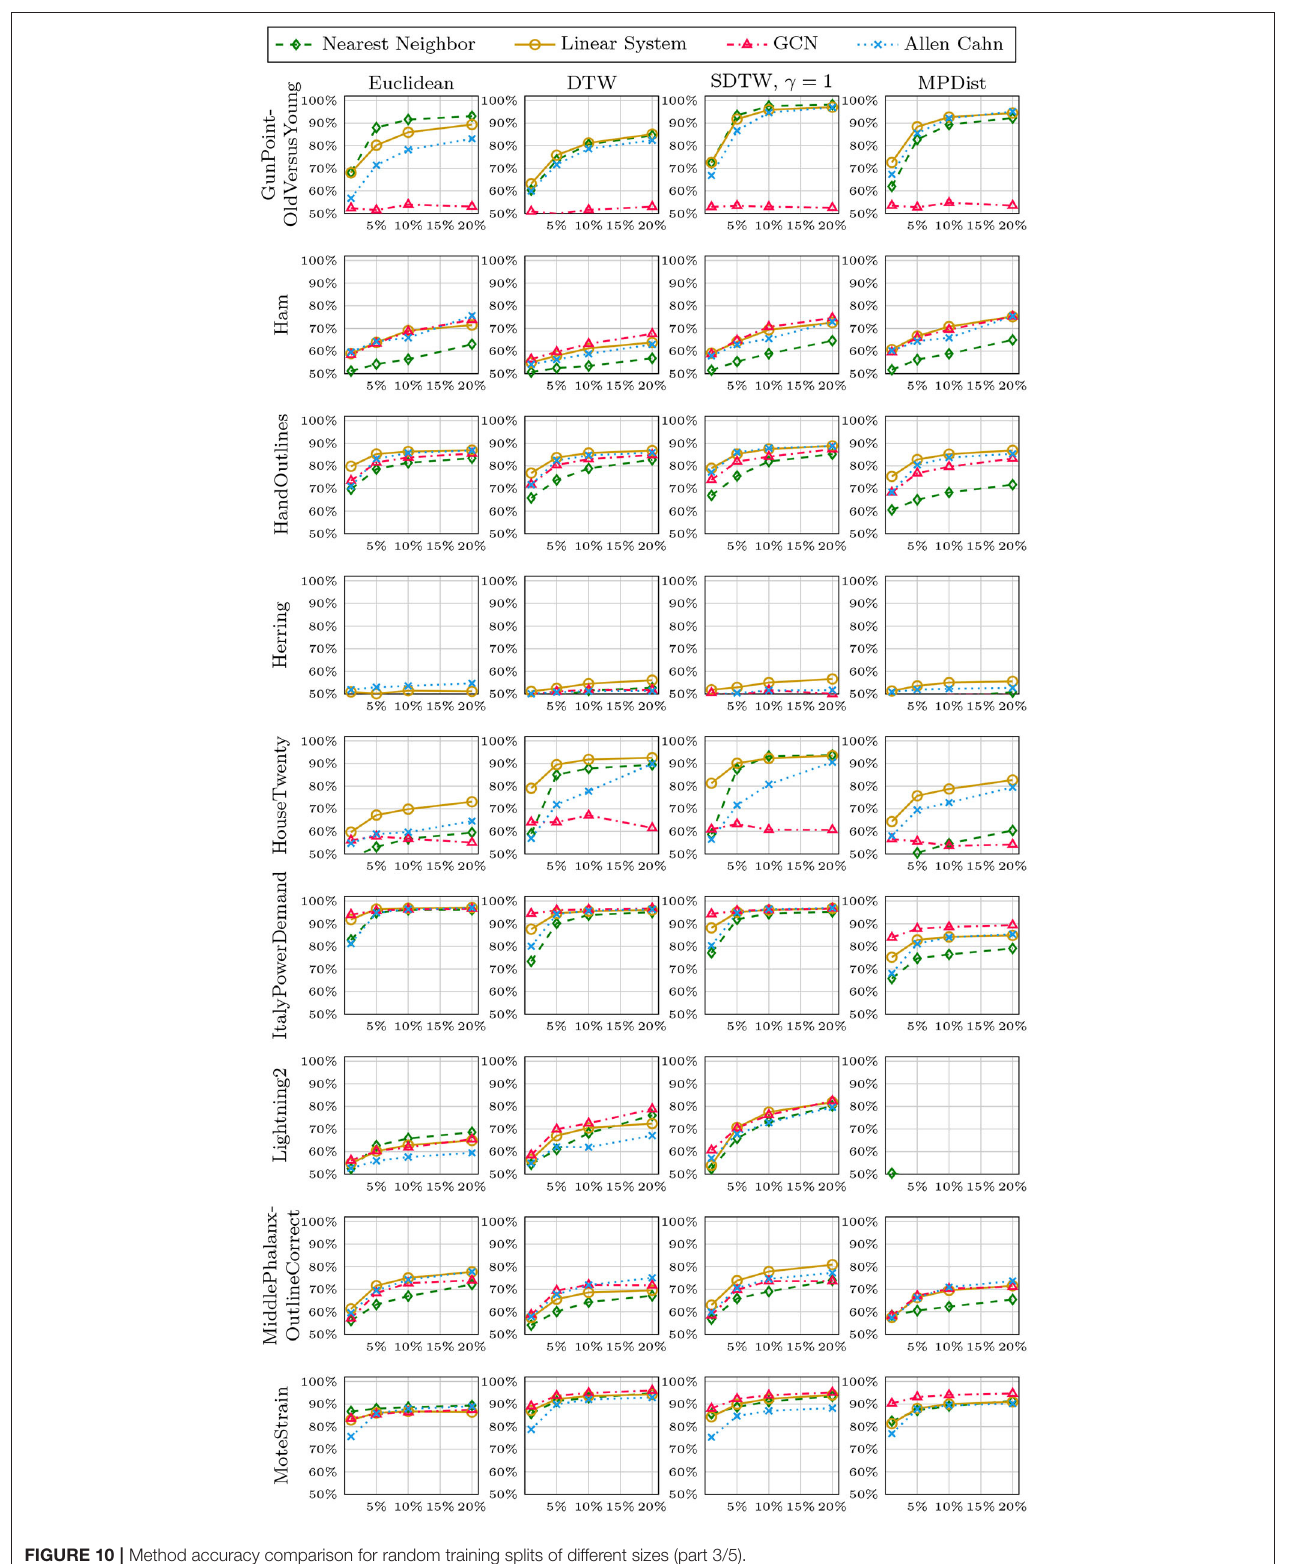
FIGURE 10 | Method accuracy comparison for random training splits of different sizes (part